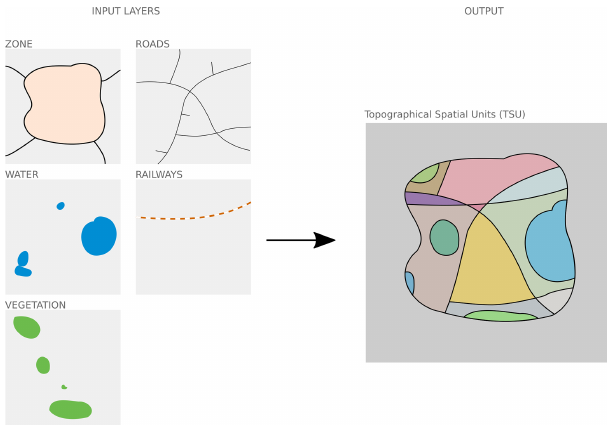
Figure 3. Example of topographical spatial unit calculation.